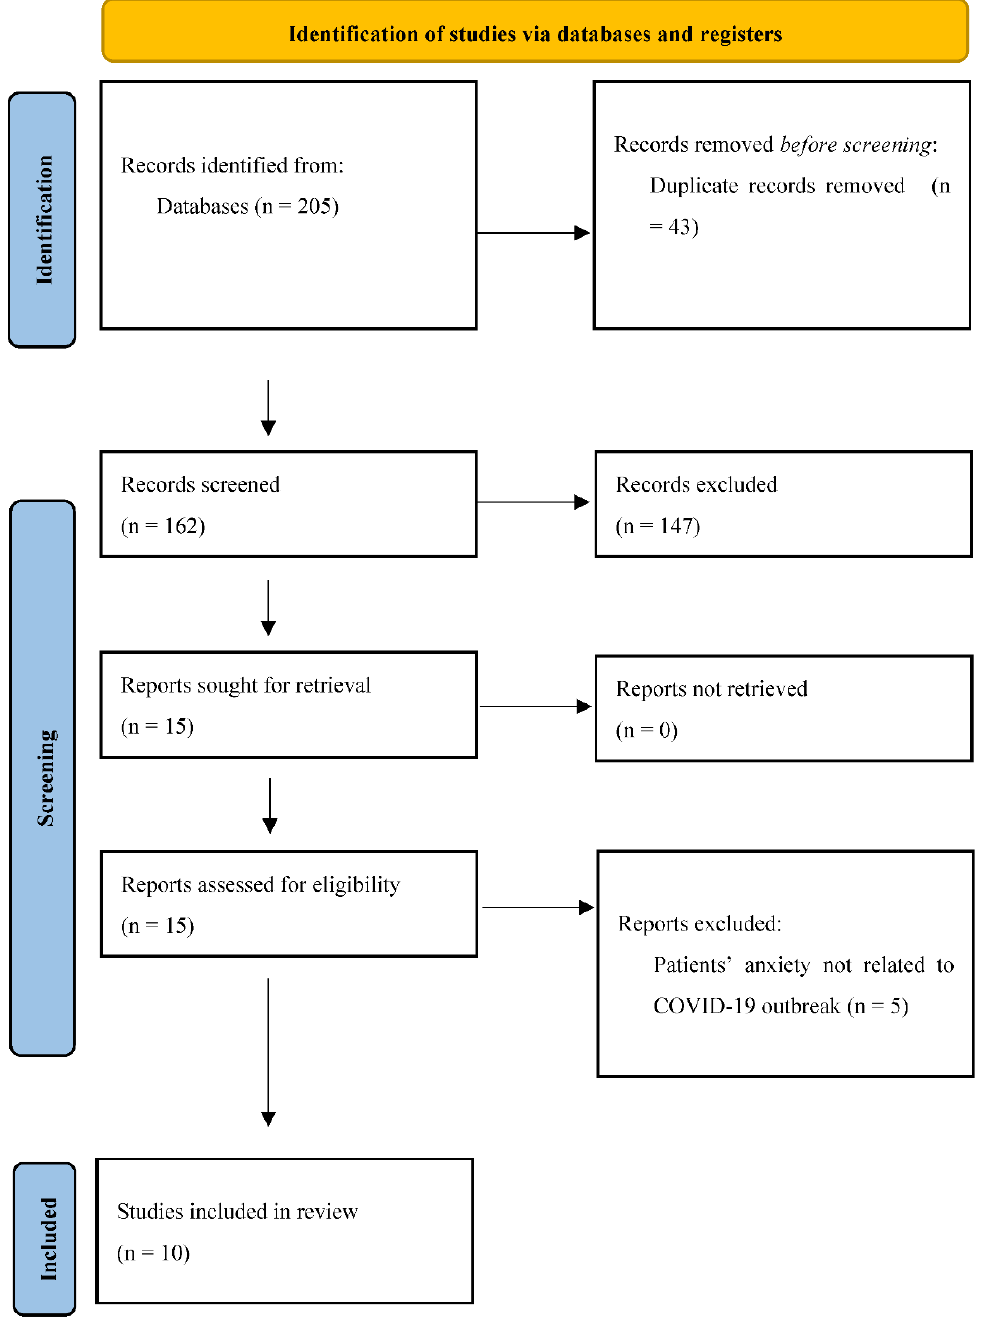
Figure 1. PRISMA Figure 1. PRISMA Flow-chart.